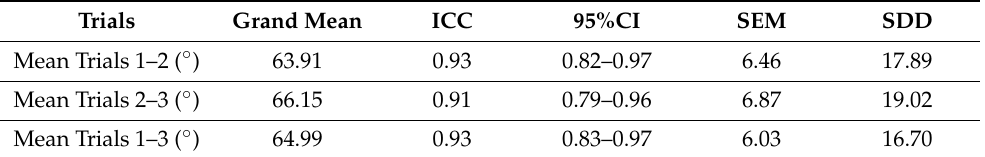
Table 7. Test-retest reliability of the double inclinometer method for the assessment of thoracolumbar range of